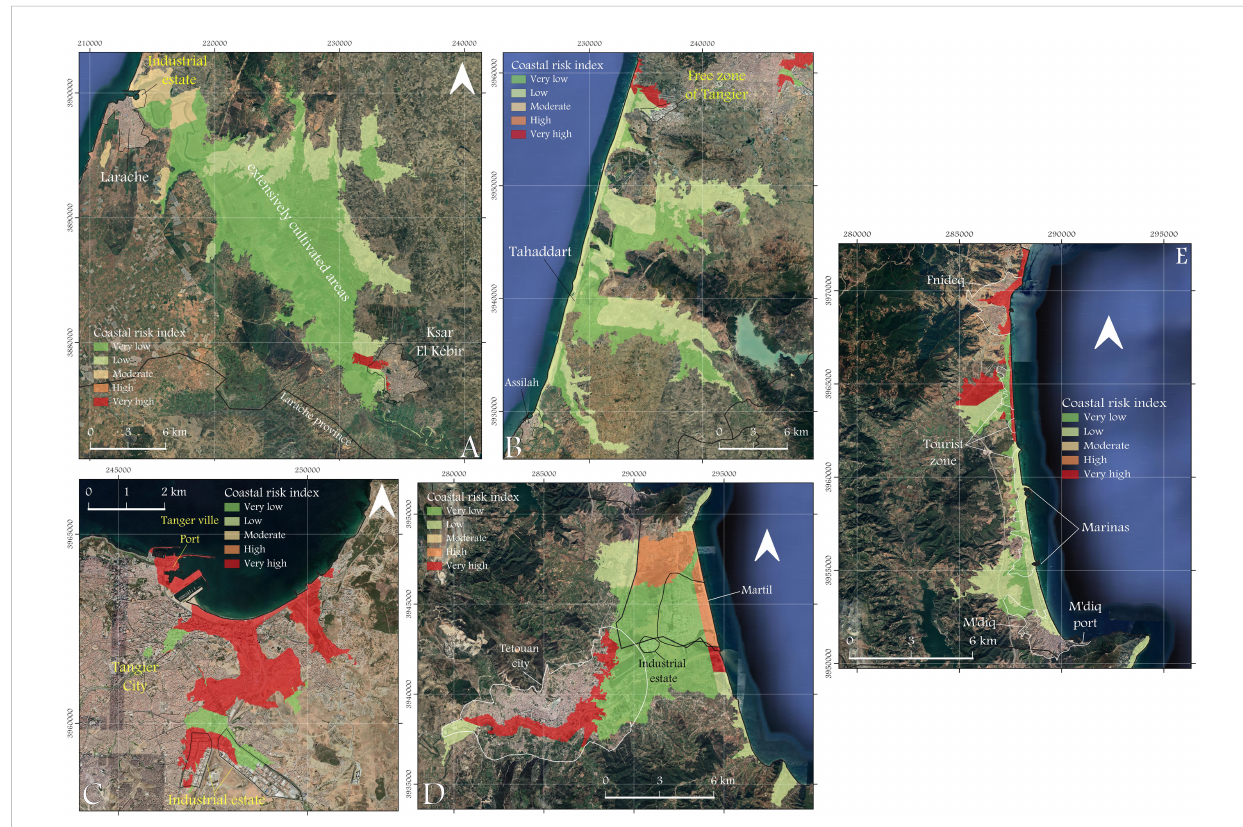
FIGURE 5 Maps focused on the most economically and demographically signi fi cant zones to de fi ne the hotspot locations in terms of coastal risk. (A) Larache, (B) Assilah-South of Tangier sector, (C) Bay of Tangier, (D) Tetouan, (E) Fnideq-M ’